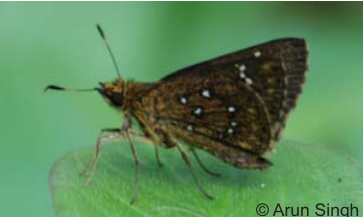
Image 55. Atkinson’s Bob Arnetta atkinsoni